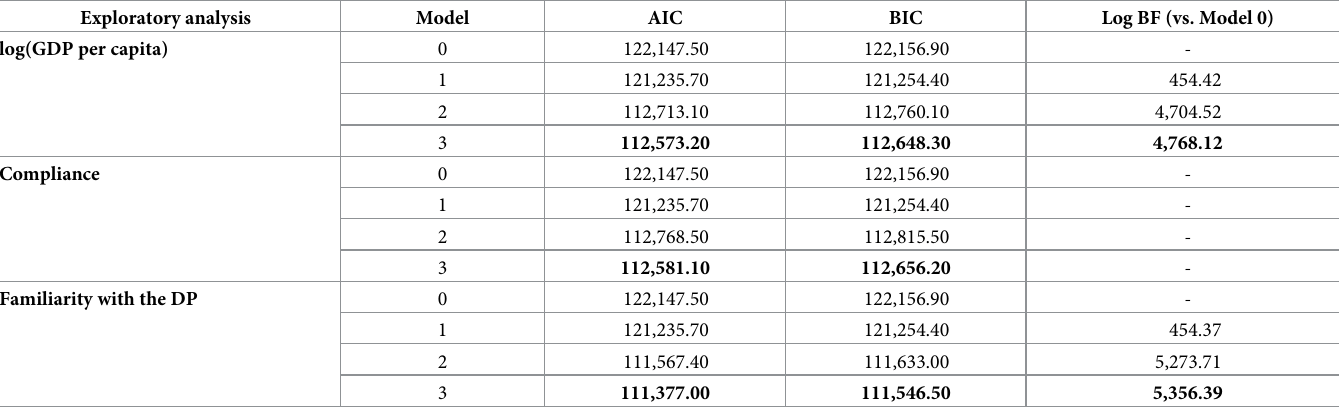
Table 4. Exploratory analyses: Model comparison.